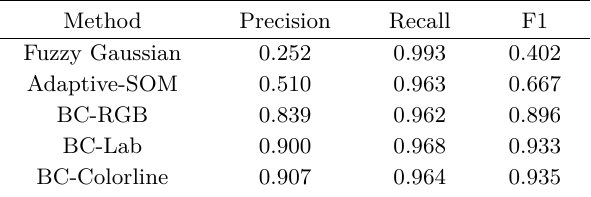
Fig. 8 Example frames for creating ground truth. Table 1 Method comparison on ground truth dataset